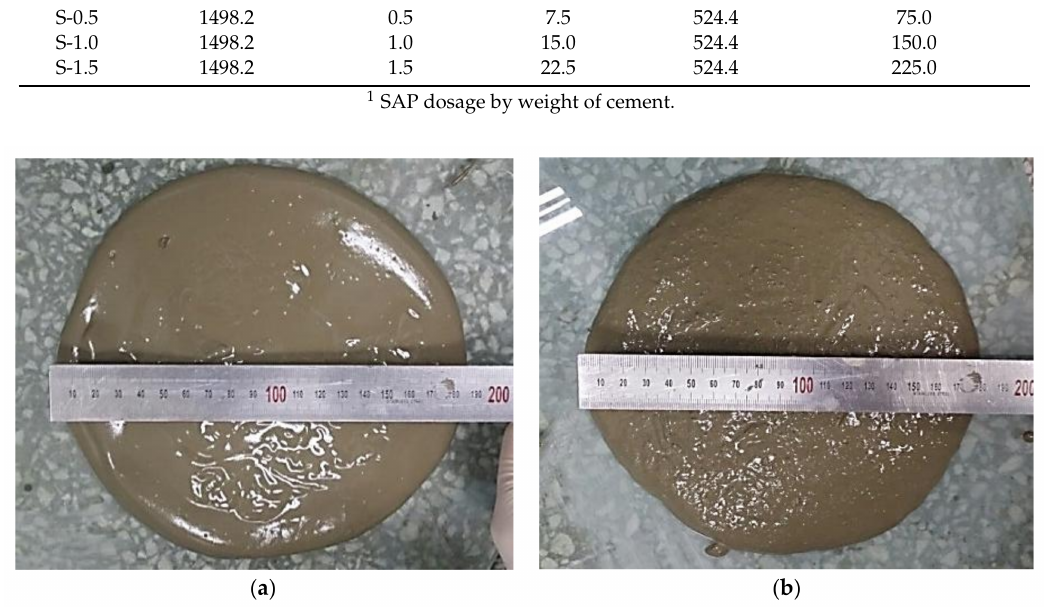
Figure 1. Flow measurement of ( a ) reference specimen (REF) and ( b ) superabsorbent polymers (SAPs)-added